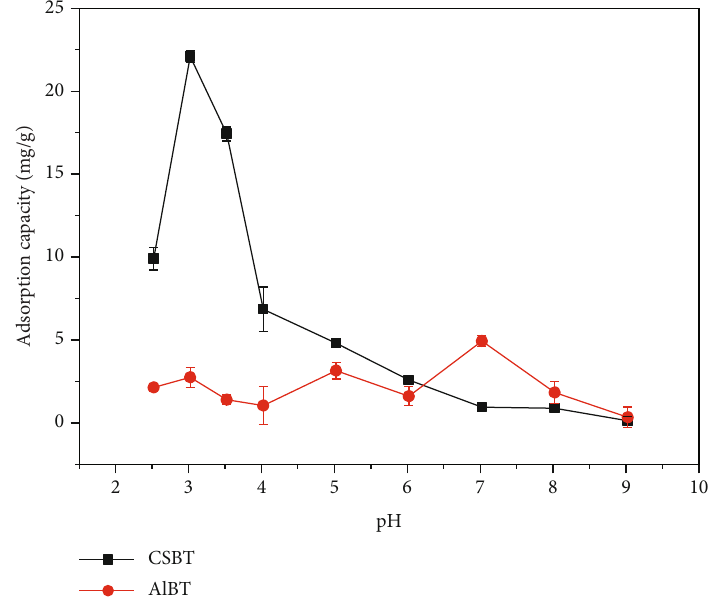
Figure 5: E ff ect of pH of Cr (VI) solutions on Cr (VI) removal by CSBT and AlBT. (absorbent dosaging, 400mg/L; initial concentration, 10mg/L; temperature, 298 K; contact time, 90min; rpm, 180).